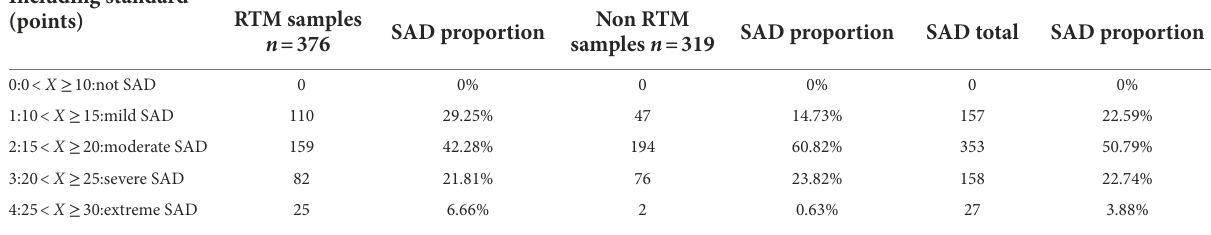
TABLE 2 Statistics of tourists with